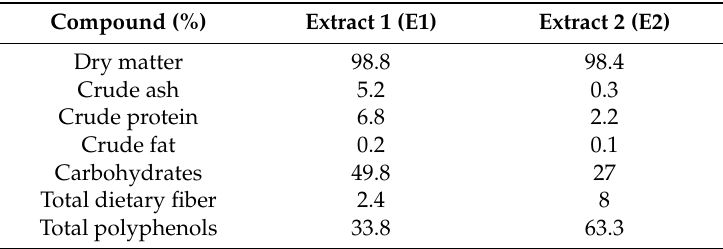
Table A1. Basic compounds of the raspberry extracts.